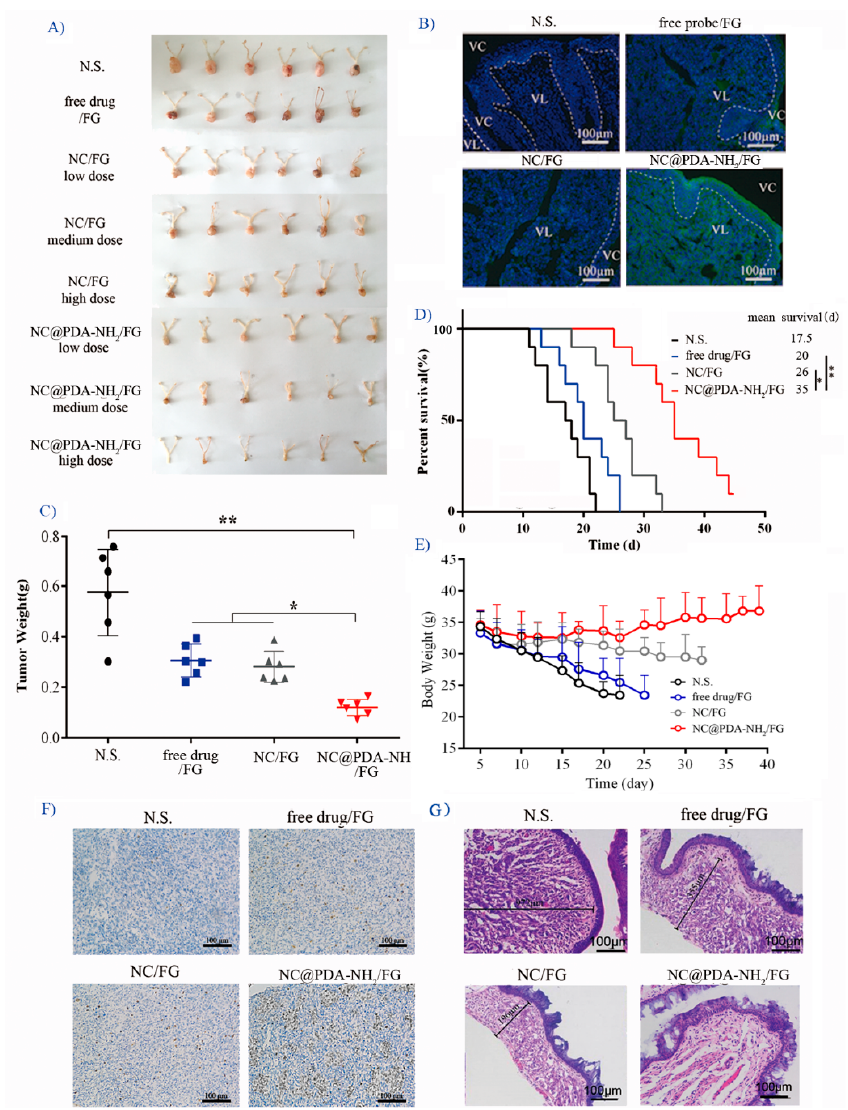
Figure 6. In vivo evaluation in orthotopic TC ‐ 1 cervicovaginal model tumor ‐ bearing mice after intravaginal administration of different formulations every other day. ( A ) Dose ‐ dependent inhibition on the tumor size after three ‐ week treatment (dose: 2, 4, and 8 mg/kg/2 d). ( B ) Penetration of fluorescent signal into the vaginal mucosa (4 h after administration). ( C ) Tumor weights after treatment for three weeks (dose: 4 mg/kg/2 d; n = 6). ( D ) Survival time (dose: 4 mg/kg/2 d; n = 10). ( E ) Change in anima body weight (dose: 4 mg/kg/2 d; n = 10). ( F ) Representative immunohistochemical microphotographs of tumor sections stained for apoptosis after three ‐ week treatment (dose: 4 mg/kg/2 d). ( G ) Representative H&E microphotographs of tumors and vagina after three ‐ week treatment (dose: 4 mg/kg/2 d). * indicates p < 0.05, ** indicates p < 0.01.